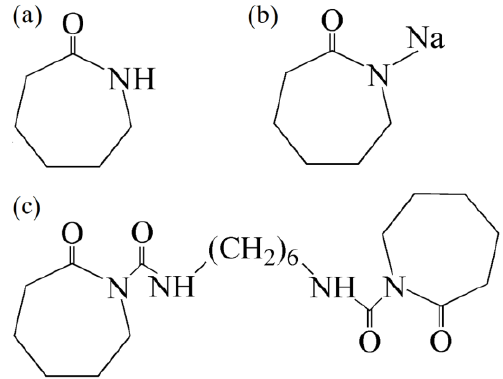
Figure 1. Structures of materials used in this study: ( a ) caprolactam, ( b ) sodium caprolactamate, and ( c ) hexamethylene-1,6-dicarbamoylcaprolactam.